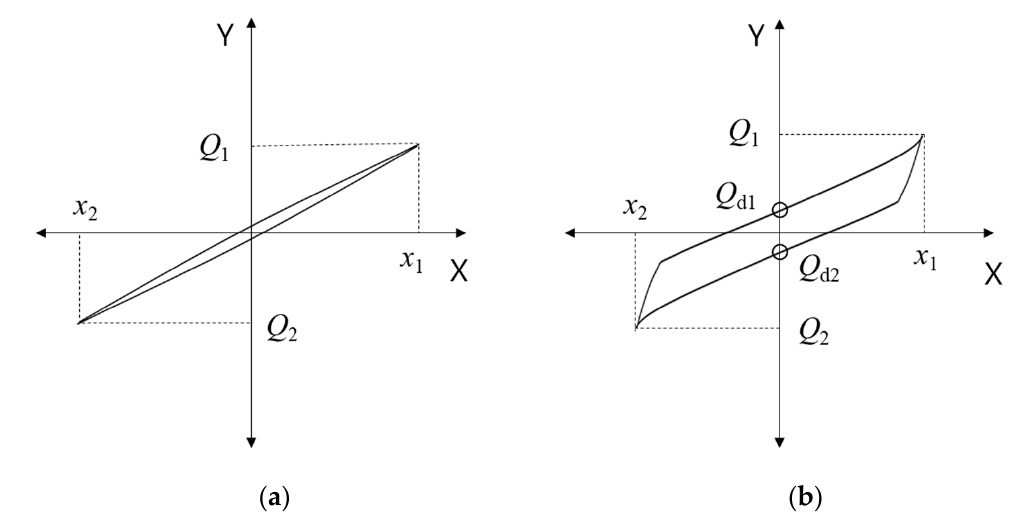
Figure 7. Shear behavior of isolators: ( a ) NRB; ( b ) LRB and EQS.